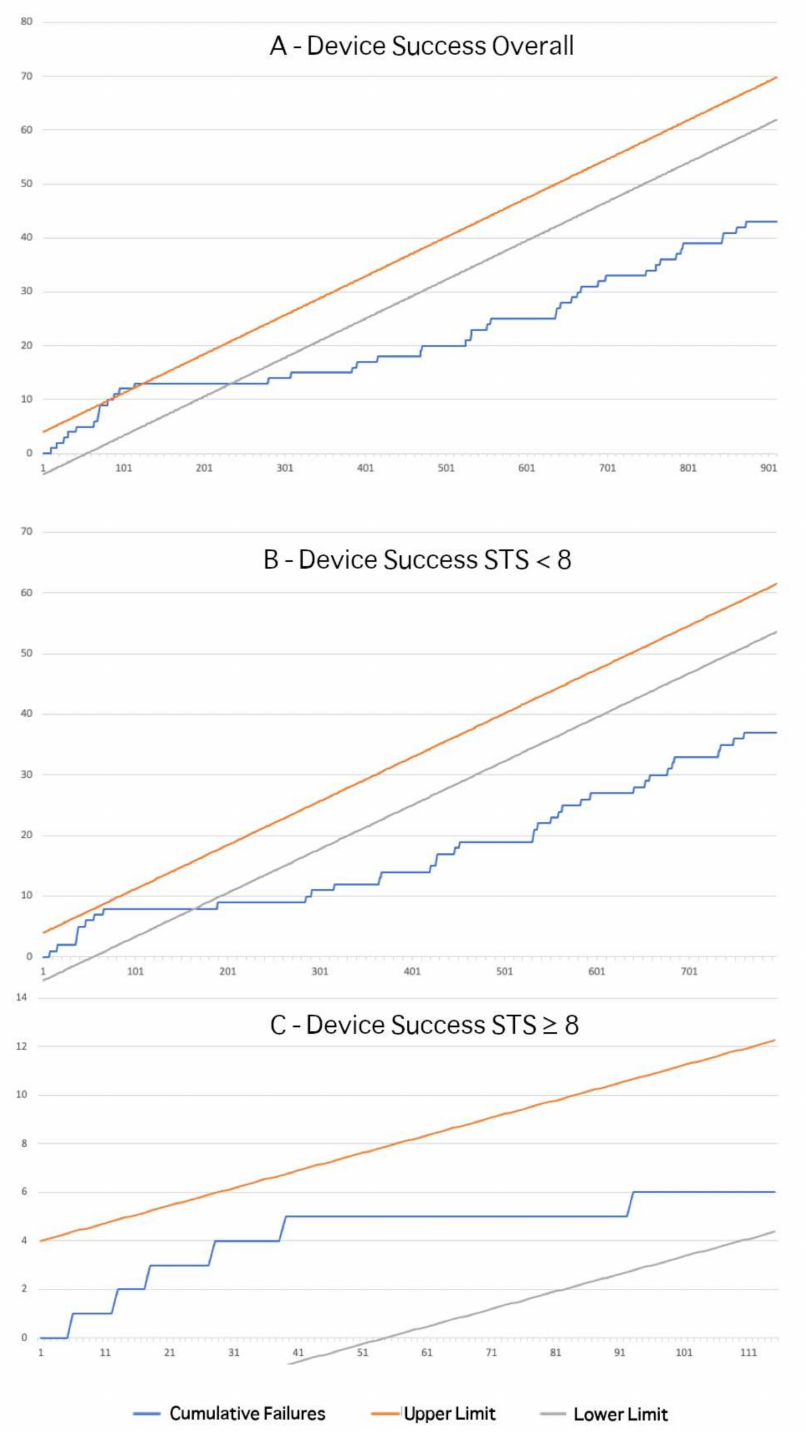
Figure 2. CUSUM Analysis for device success. Incremental line represents unadjusted cumulative sum of failures. Lower and upper limits are calculated upon acceptable and unacceptable failure rates of 5% and 10%, respectively. Observations above the upper limit indicate out of control procedure, while observation below the lower limit suggest better-than-expected results (proficiency). CUSUM analyses are provided for the overall population ( A ), low-intermediate risk ( B ), and high-risk subgroups ( C